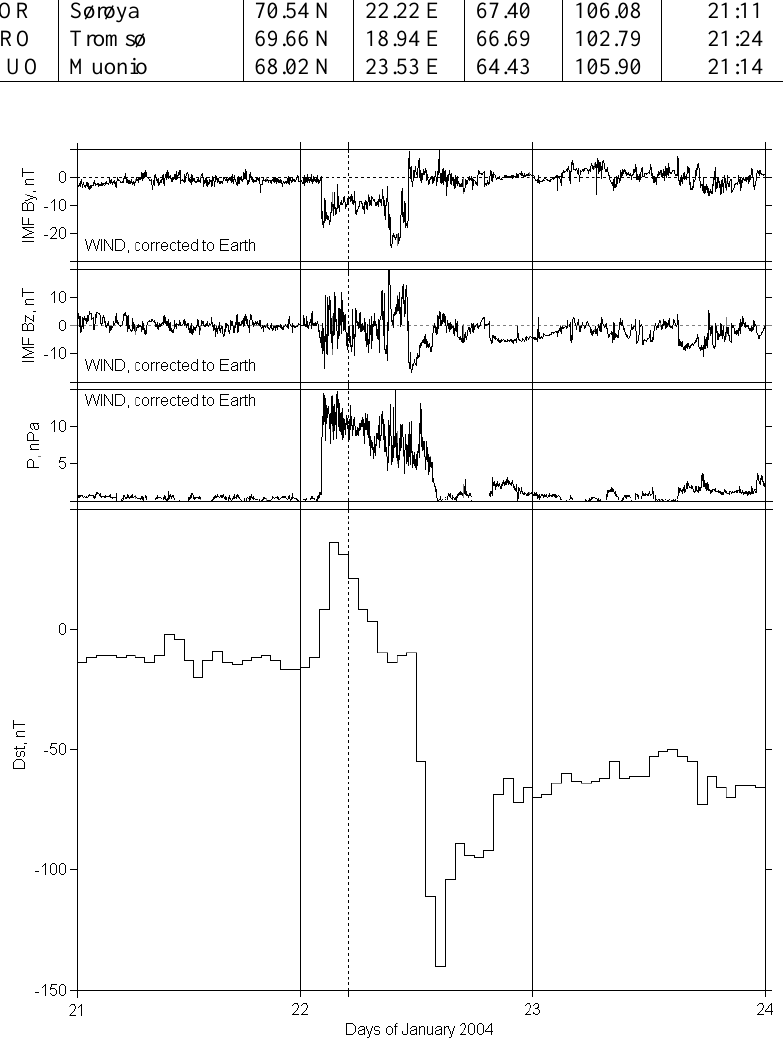
Fig. 2. The signatures of the magnetic cloud in space (three top plots) and on the ground. The time of torch observation is indicated with a vertical dashed line at 06:03